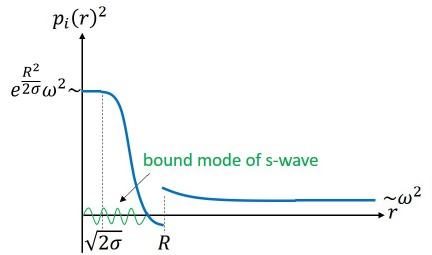
) . Bound modes of s-wave can emerge a